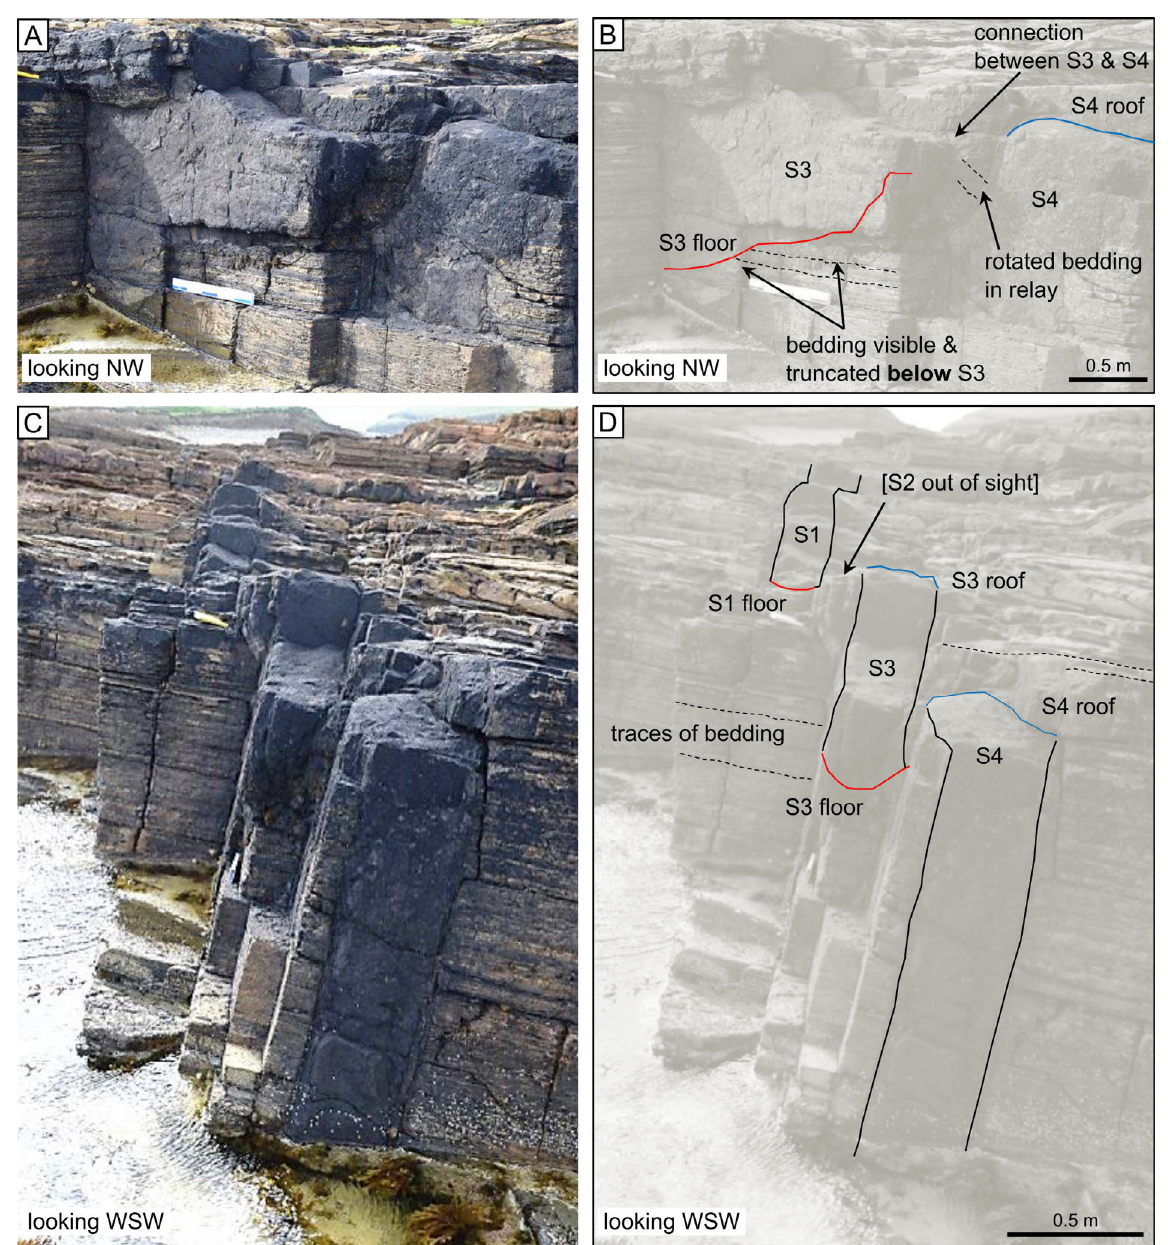
Figure 8: Further field observations from Relay B on Dyke 1. [A]–[B] Photograph and interpretation of the relationships between S3 and S4 at the eastern end of the relay. Looking NW onto a nearly vertical section along the southern margin of S3. The floor to S3 can be seen, with bedding in the host rock truncated against the dyke contact. The connection between S3 and S4 is complex, with rotated steepened bedding. [C]–[D] Photograph and interpretation of S3 and S4 looking WSW. The floor to S3 is clearly visible with host rock bedding beneath. The roof to S4 is also visible with bedding in the host rock continuous above. In the background, the floor to S1 is also